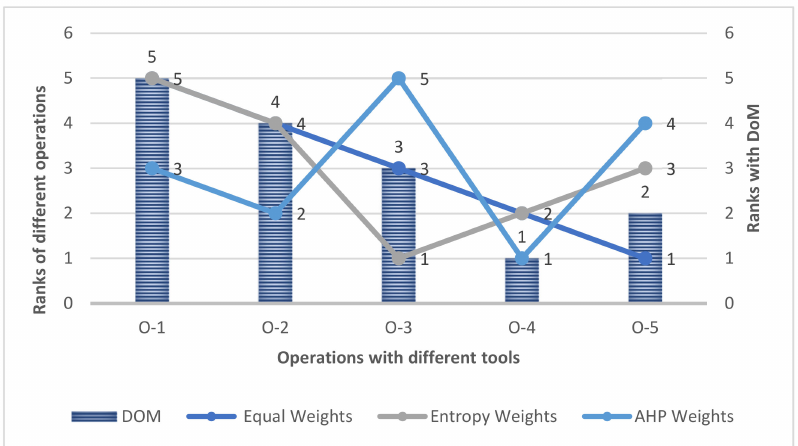
Figure 10. Ranks established using different weight methods, along with the final rank determined using a degree of